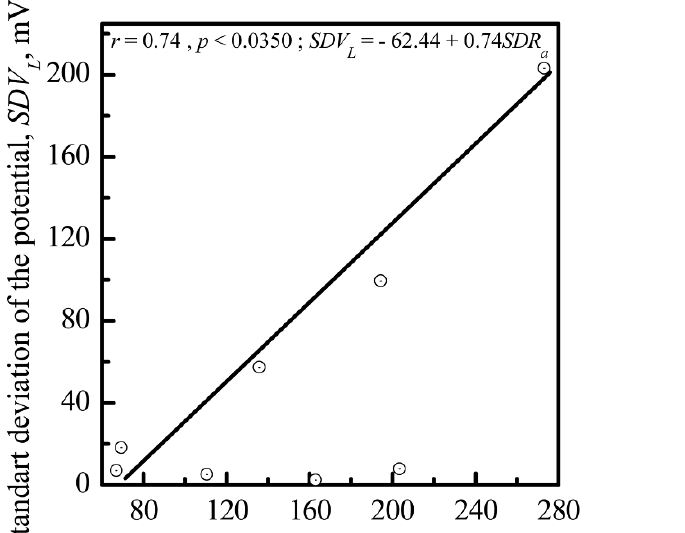
Figure 15. Correlation and interconnection of the standard deviations of surface potential ( SDV L ) and surface irregularity ( SDR a ) for the CP surface.